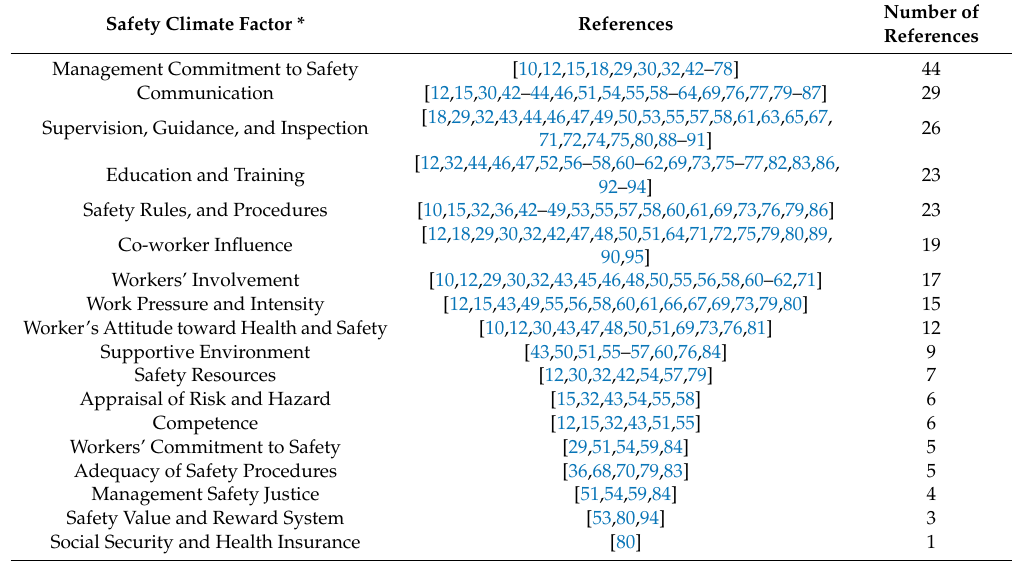
Table 2. List of extracted factors influencing safety climate at construction project sites from the previous literature.